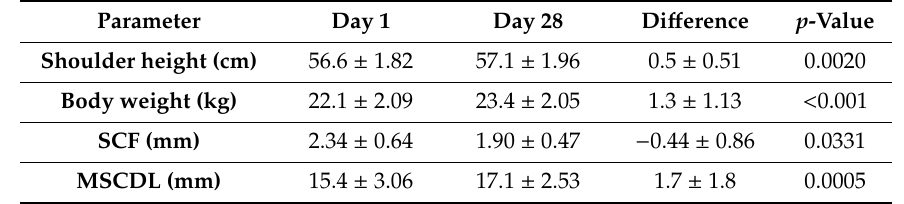
Table 3. Shoulder height, body weight, and thickness of subcutaneous fat tissue (SCF), Musculus